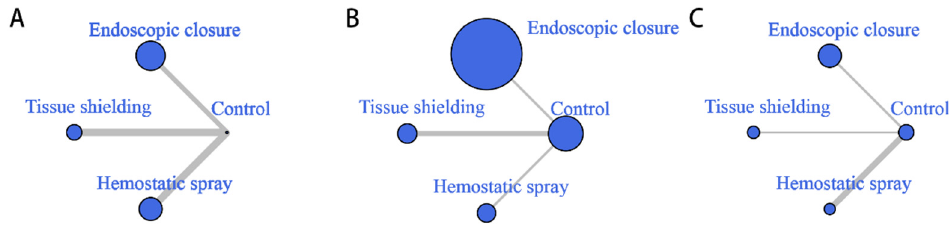
Figure 3. Network graph of the included studies: ( A ) in patients overall; ( B ) in high-risk patients; ( C ) in low-risk patients. The size of the node is proportional to the number of participants in the group (in ( A ), as the number of patients in the control group is much larger than the number in other groups, the control group node size is collapsed for graph neatness), and the width of the edge is proportional to the number of studies comparing two approaches.